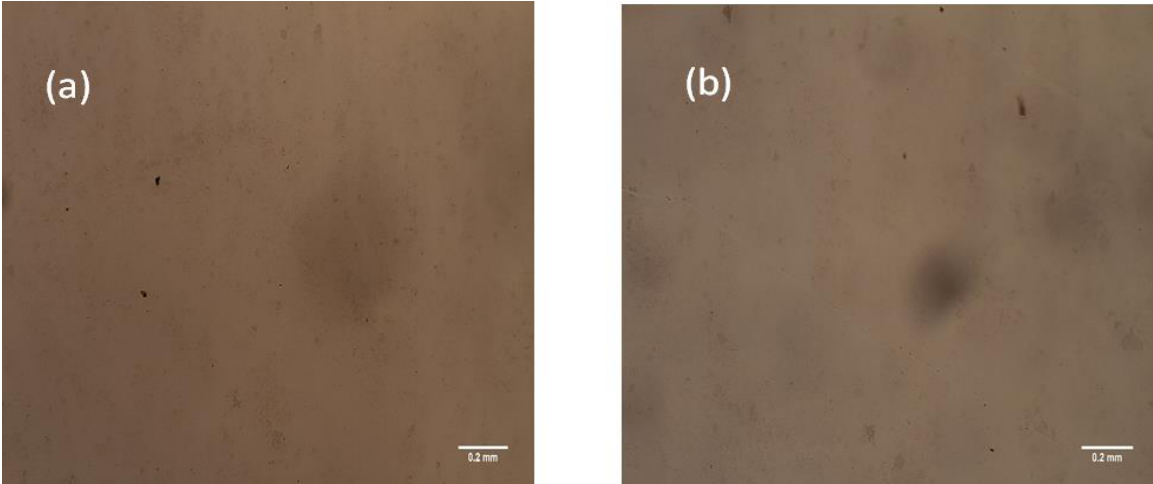
Figure 1. ( a ) Optical microscopy images of GO and ( b ) RGO films after thermal annealing.